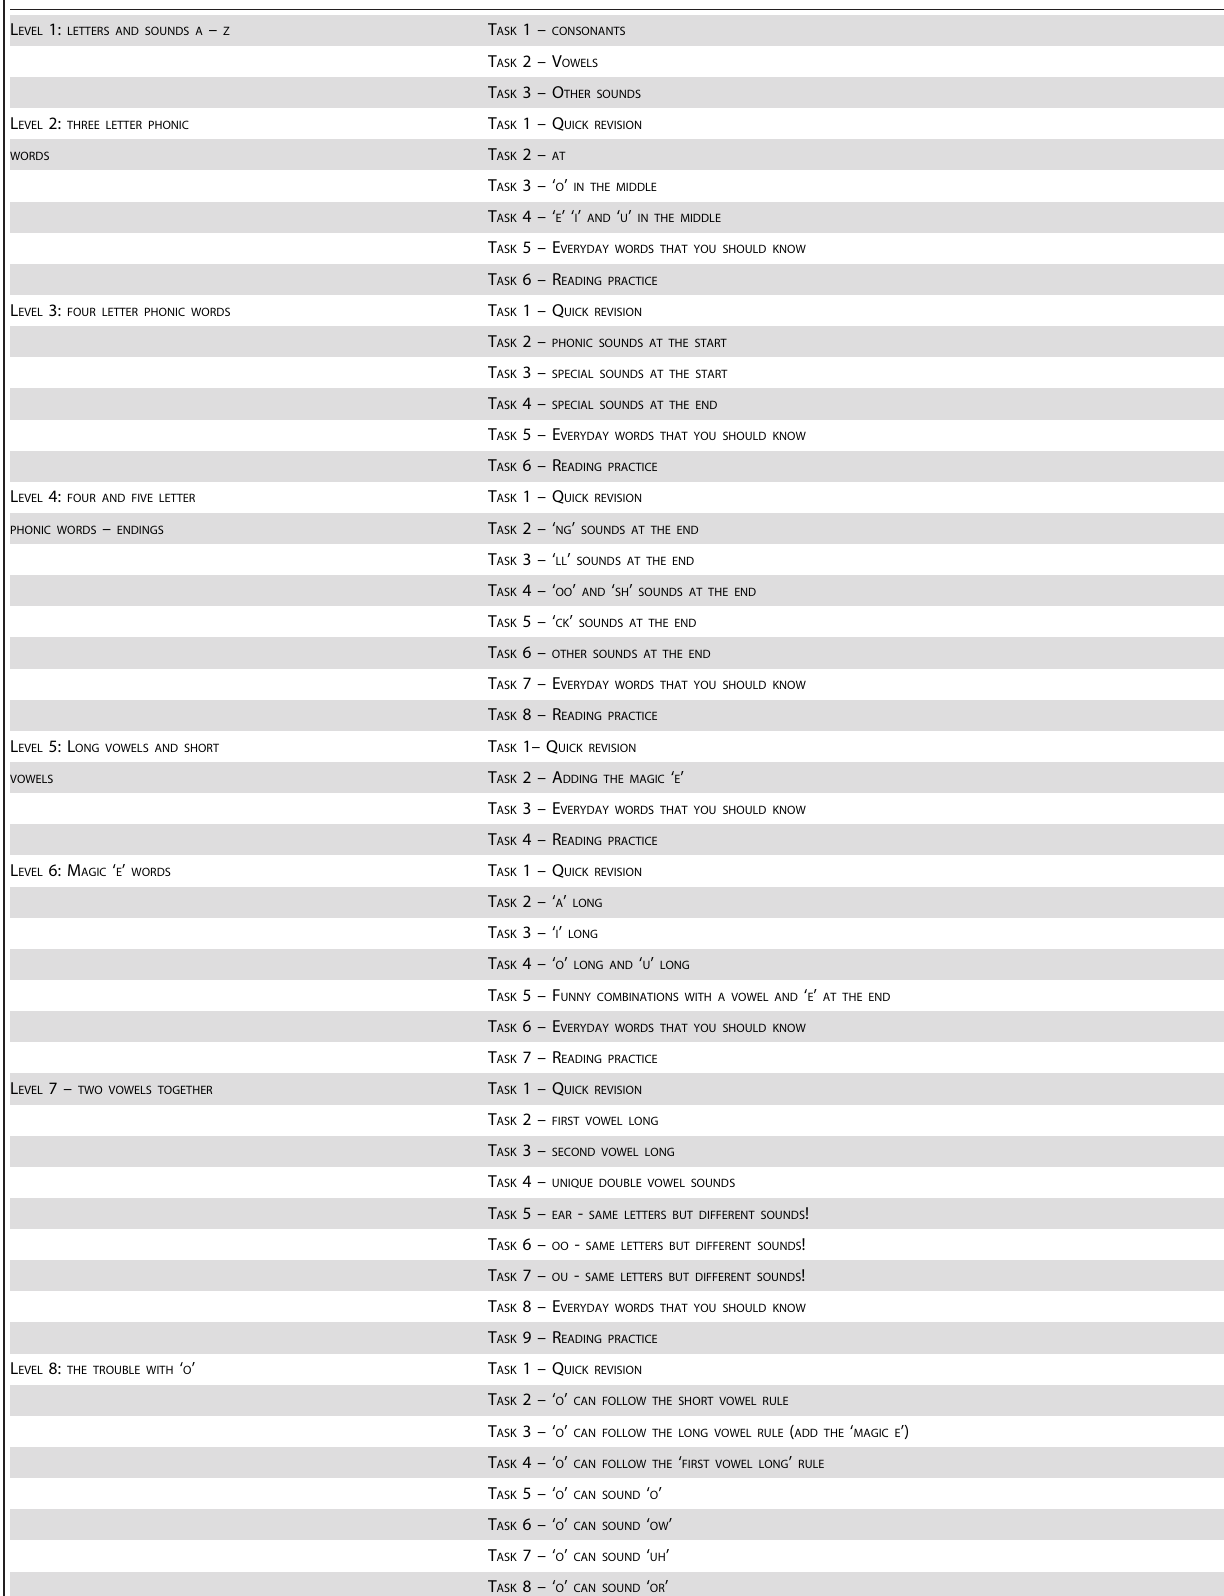
Table 2. Levels and tasks in the Self Learn Read and Spell